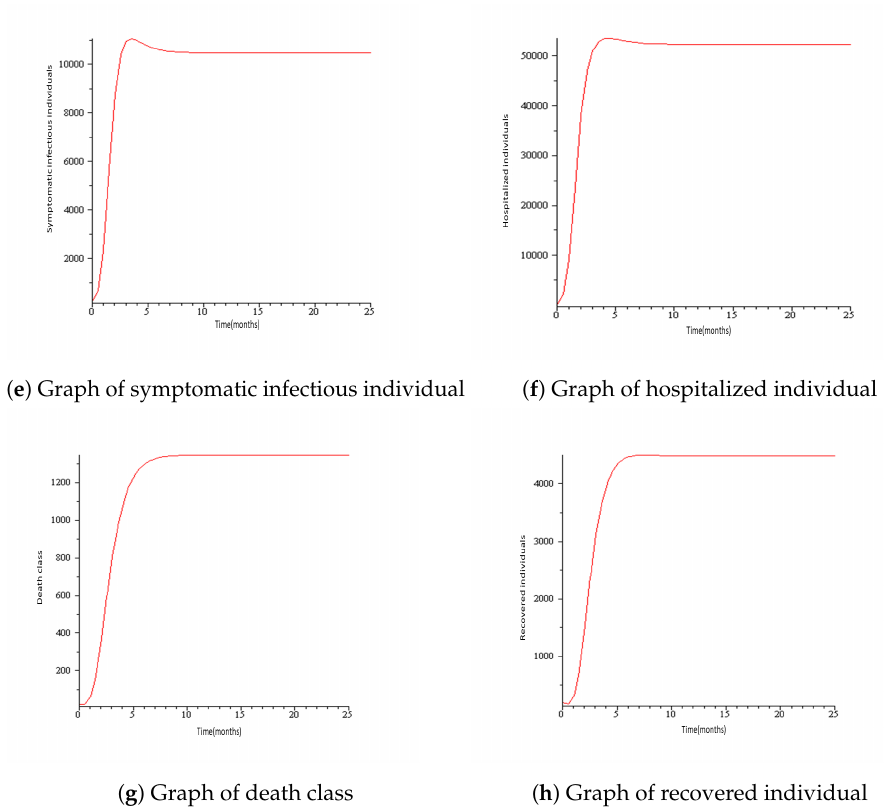
Figure 4. Simulation results showing the global stability of the endemic